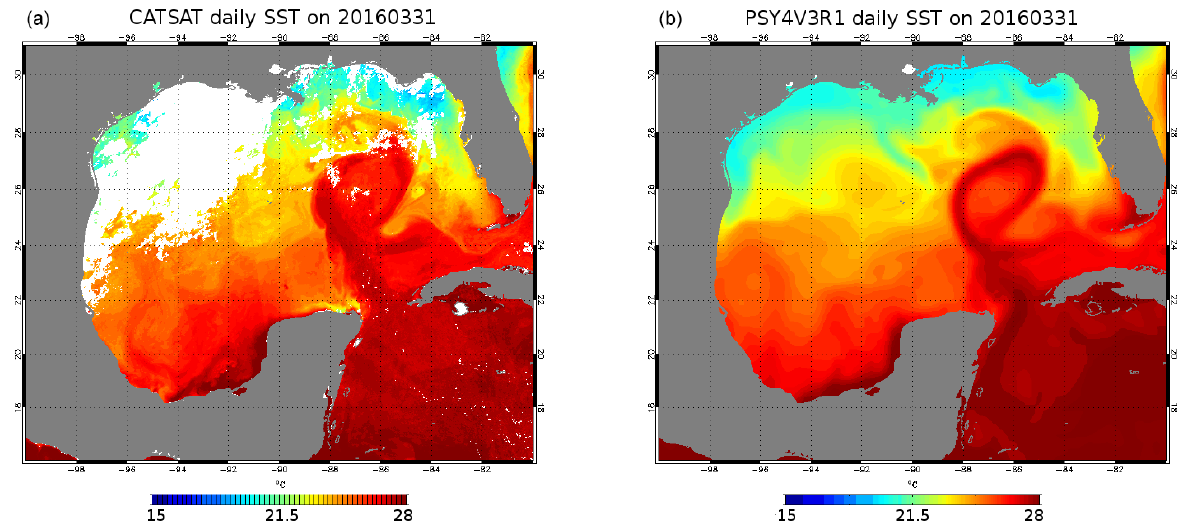
Figure 22. High-resolution CATSAT SST from CLS (a) and PSY4V3 SST (b) on 31 March 2016. Unit is ◦ C.